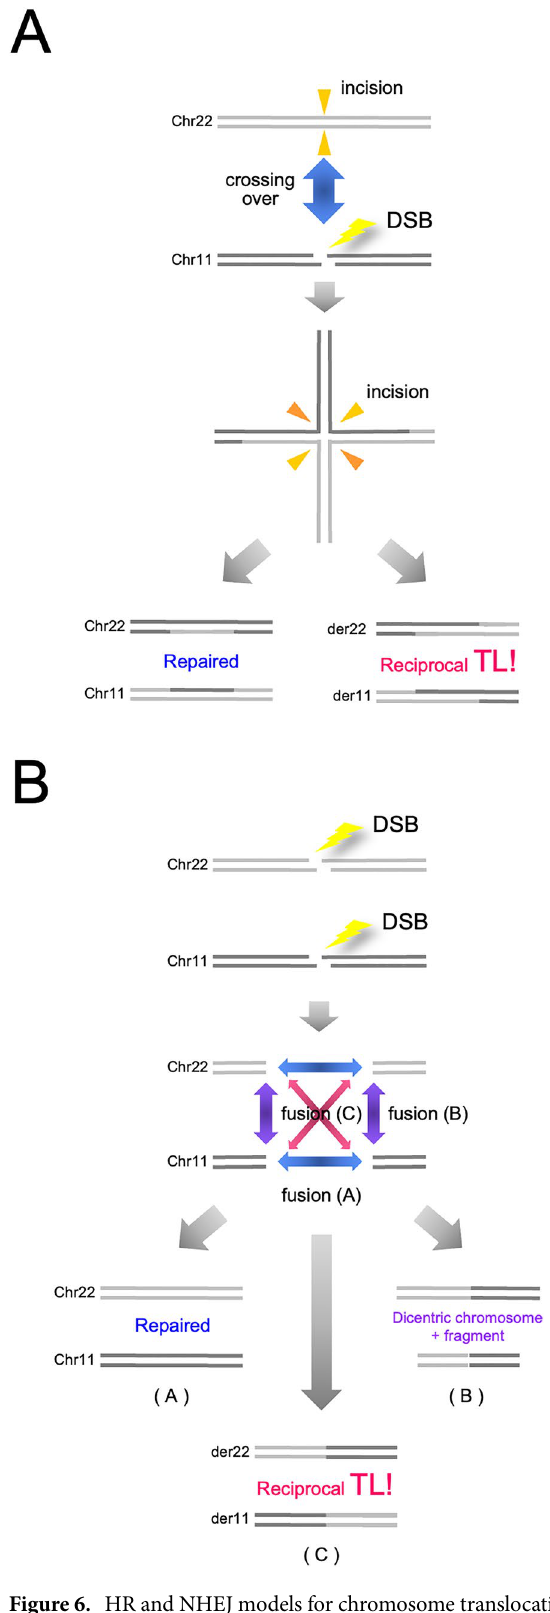
Figure 6. HR and NHEJ models for chromosome translocation. The HR ( A ) and NHEJ ( B ) models to explain t(11;22) chromosome translocation are schematized. In the HR model, one DSB is required in either chromosome, and TL is obtained with a 1/2 chance. On the other hand, in the NHEJ model, two DSBs are necessary in both chromosomes, and the probability of reciprocal TL is 1/3. The results also include dicentric chromosomes and